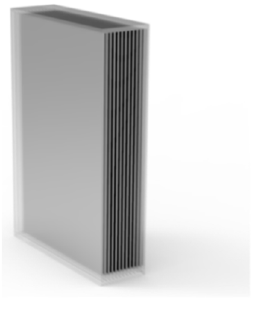
Figure 3. Structure of VBG.